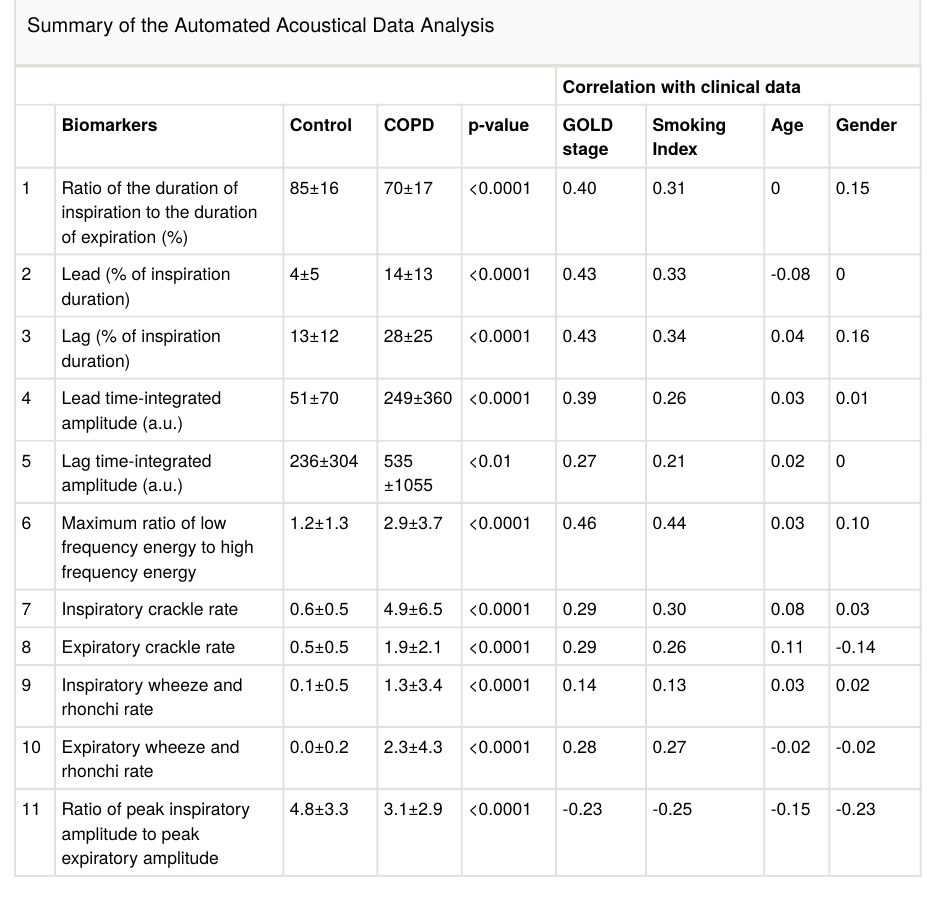
Eleven parameters were statistically di ff erent between COPD and control patients (Table